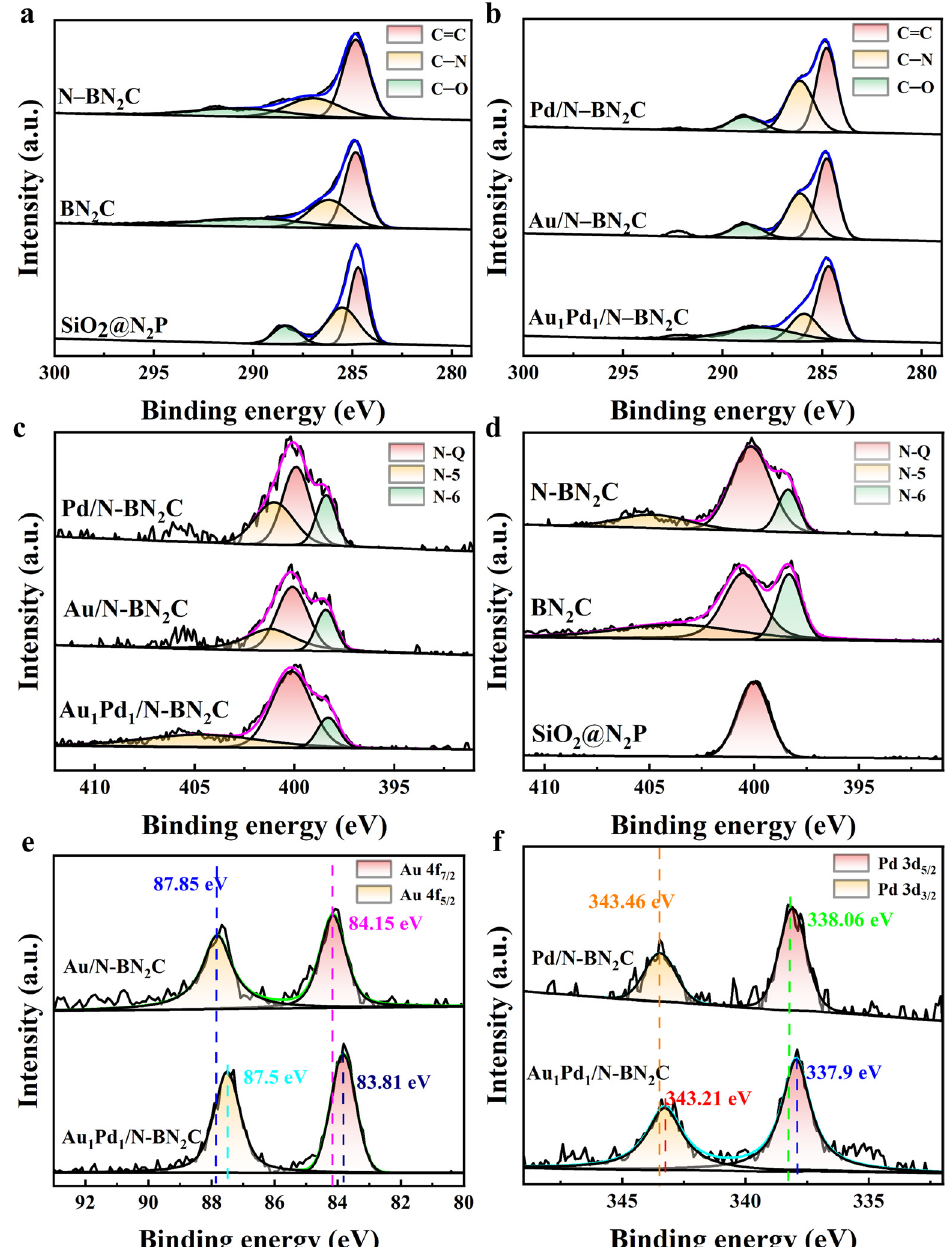
Figure 6. C 1s ( a , b ), and N 1s ( c , d ) XPS spectra of SiO 2 @N 2 P, BN 2 C, N-BN 2 C, Au/N-BN 2 C, Pd/N-BN 2 C, and Au 1 Pd 1 /N-BN 2 C. Au 4f ( e ) and Pd 3d ( f ) XPS spectra of Au/N-BN 2 C, Pd/N-BN 2 C, and Au 1 Pd 1 /N-BN 2 C.